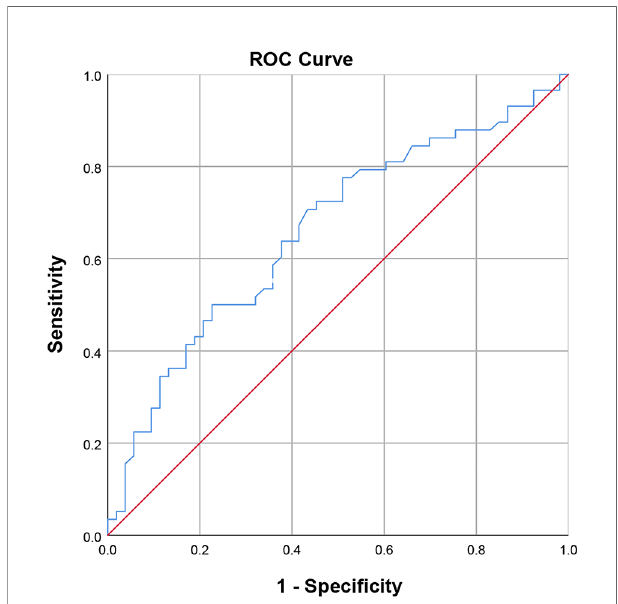
FIGURE 2 | Receiver operating characteristic curve of the preoperative platelet count (area under the curve = 0.661, standard error = 0.052,